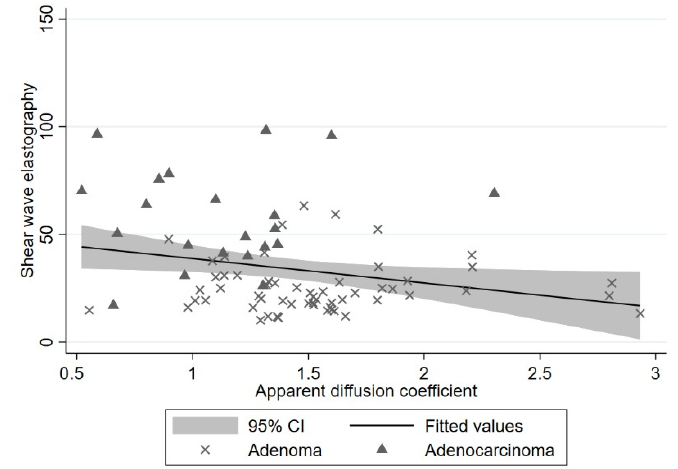
Figure 5. Correlation between shear-wave elastography (SWE) in kPa and apparent diffusion coef- ficient (ADC) in 10 − 3 mm 2 /s. There is a negative correlation with a p -value of 0.025. Each point is plotted with the SWE value and the corresponding ADC value. X represents an adenoma, and a triangle represents an adenocarcinoma. The line represents the fitted values, and the grey area rep- resents the 95% confidence interval.